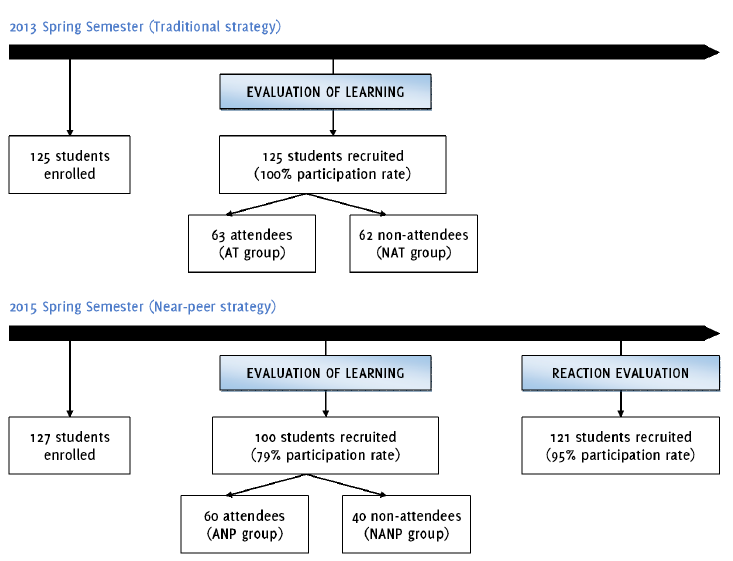
Figure 1. Study Design and Flow of